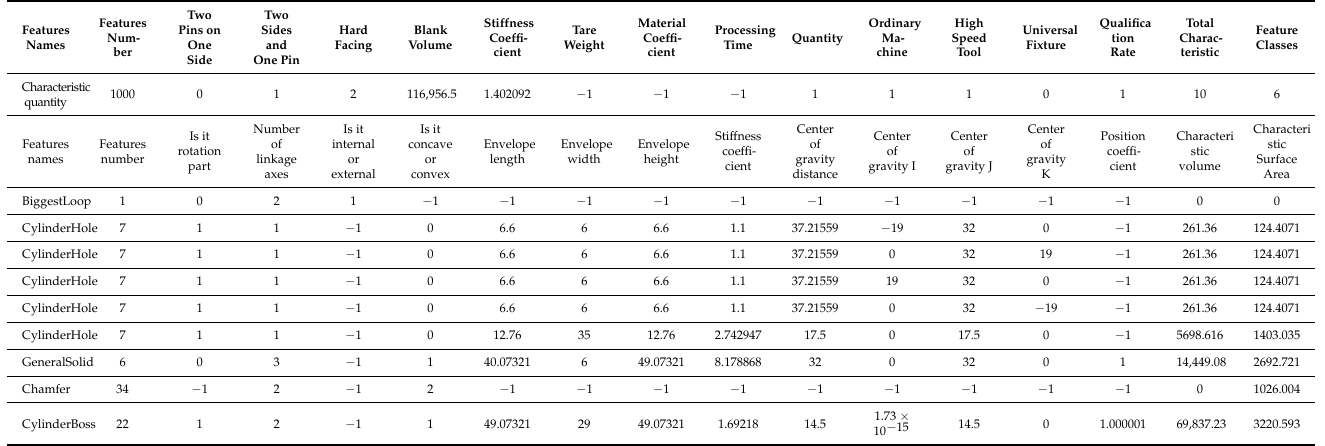
Table 5. Shows the results of the first half of the feature recognition and quantities in comma-separated value (CSV) file.